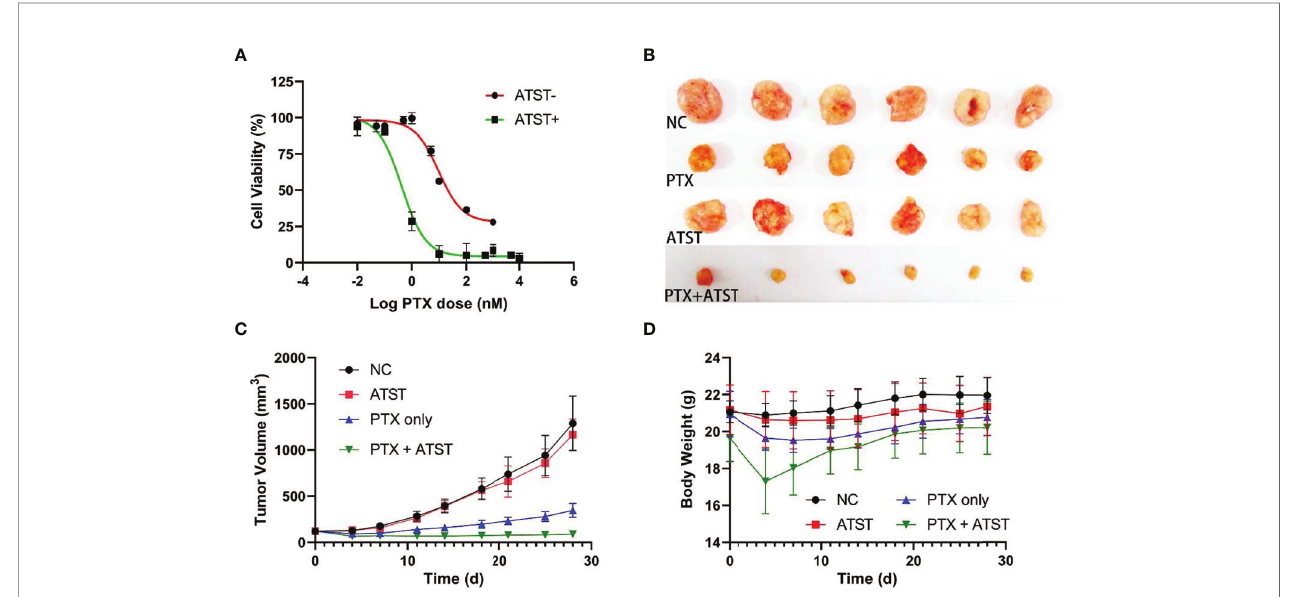
FIGURE 2 | (A) IC 50 of paclitaxel (PTX) in atorvastatin (ATST) treated and untreated SKOV-3 cells, respectively. (B) Tumor volume in mice treated with PBS, PTX only, atorvastatin only, and PTX-atorvastatin combination at Day 28. (C) Dynamic changes of tumor volume in each group for 28 days. (D) Dynamic changes in body weight of mice in 28